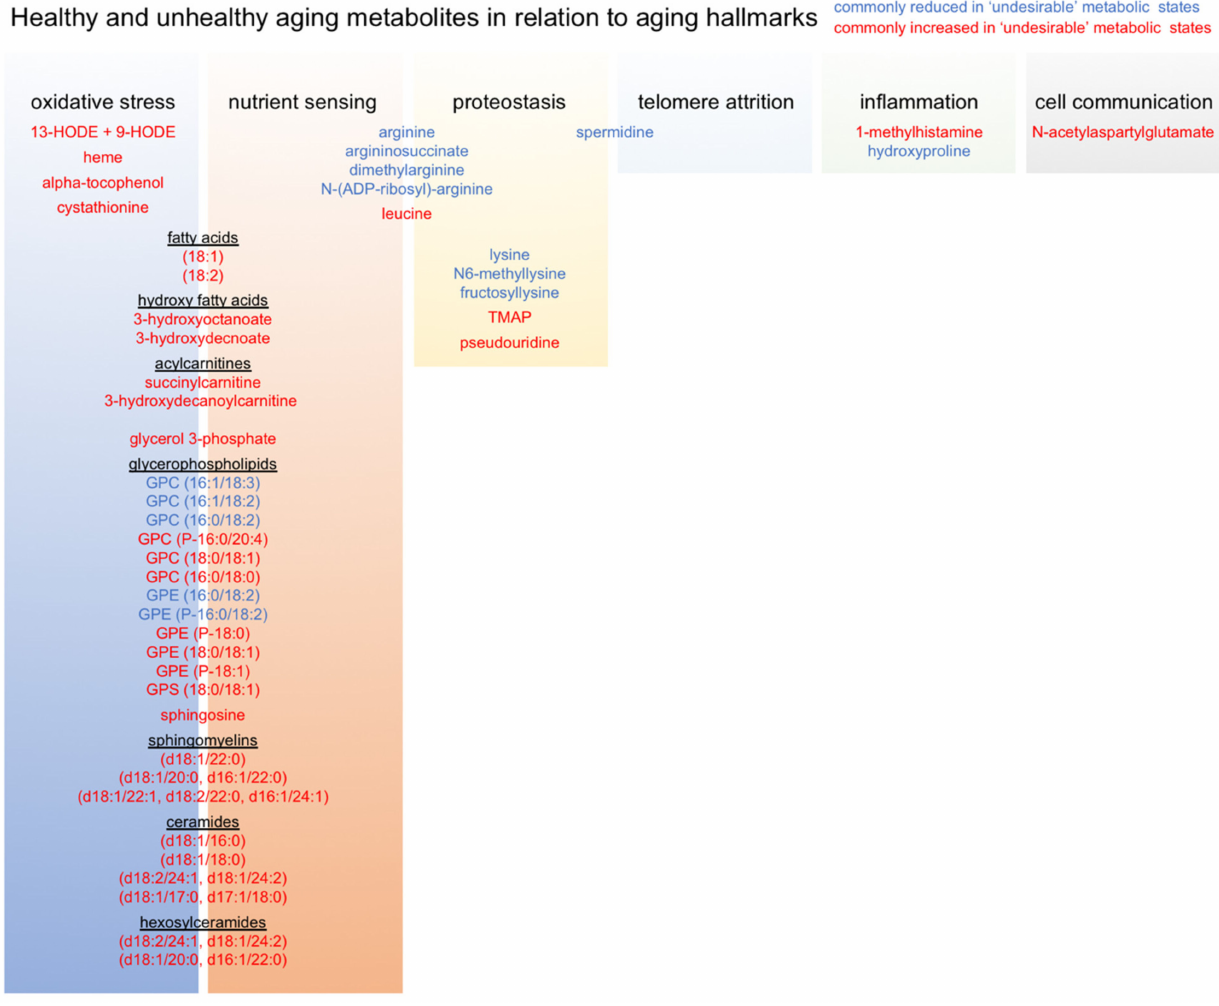
Figure 6. Relationships between metabolites associated with healthy and unhealthy aging trajectories and aging